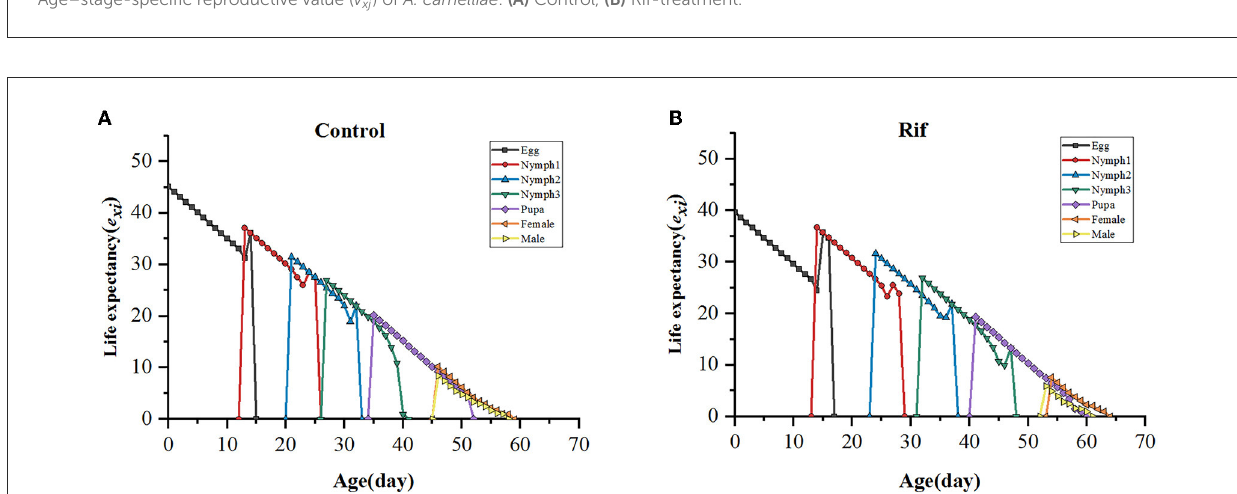
FIGURE8 Age–stage life expectancy ( e xj ) of A. camelliae in the control (A) and the rif-treatment (B)